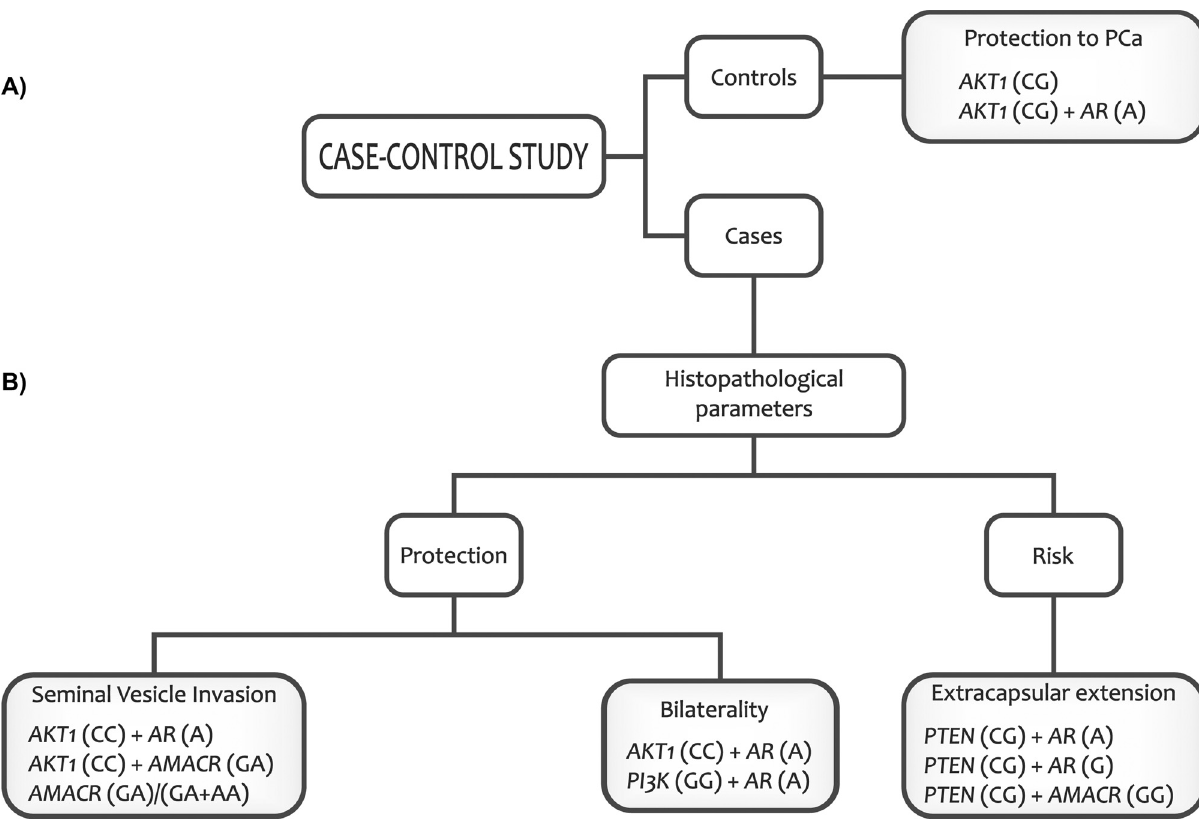
Figure 1 - An individual’s genetic profile can: (A) Identify men with genotypes that confer protection for prostate cancer. (B) Discriminate men with a better or worse prognosis for prostate